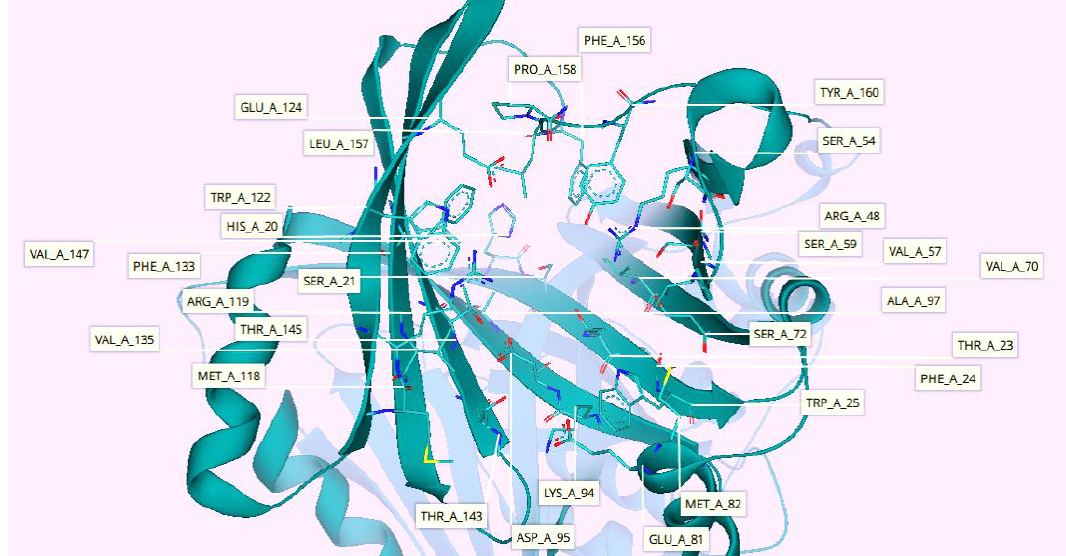
Figure 4. Three-dimensional (3D) structure of 4-hydroxyphenylpyruvate dioxygenase obtained from PDB. The figure highlights the active pocket residues (pale teal) in stick conformation, while other protein residues are represented in cartoon conformation (dark teal). Active site constitutes a total of 29 residues, including His20, Ser21, Thr23, Phe24, Trp25, Arg48, Ser54, Val57, Ser59, Val70, Ser72, Glu81, Met82, Lys94, Asp95, Ala97, Met118, Arg119, Trp122, Glu124, Phe133, Val135, Thr143, Thr145, Val147, Phe156, Leu157, Pro158, and Tyr160.